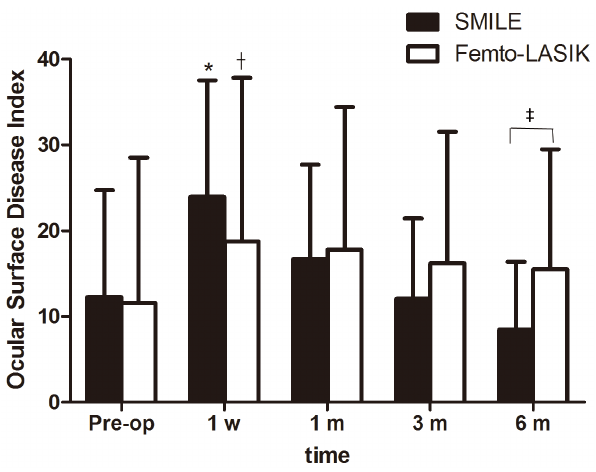
Figure 1. Time dependent changes in the Ocular Surface Disease Index (OSDI) (mean ± SD) after small incision lenticule extraction (SMILE) and femtosecond LASIK (femto-LASIK). *Significantly higher than the preoperative level (SMILE; P , 0.05). { Significantly higher than the preoperative level (femto-LASIK; P , 0.05). ` Significantly different between groups ( P , 0.05).